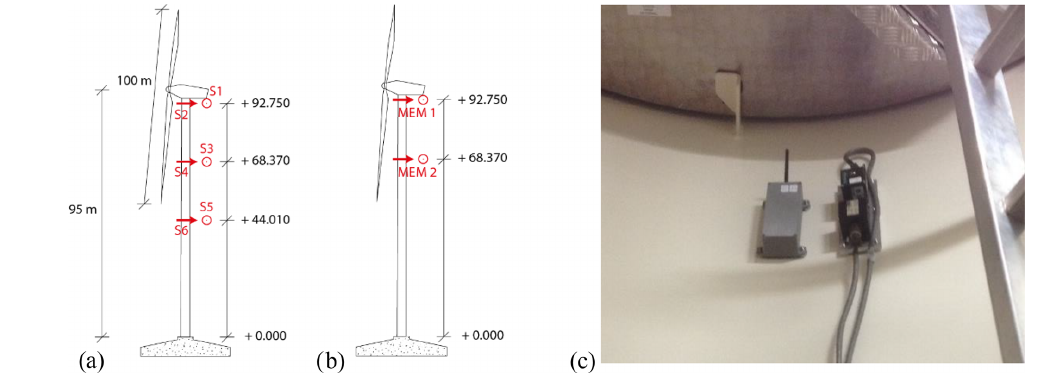
Figure 8. Sections instrumented with accelerometers: (a) force balance sensors, (b) MEM sensors, (c) photos of the force balance sensors (connected to cables) and of the MEM-based acquisition system (grey box with antenna).